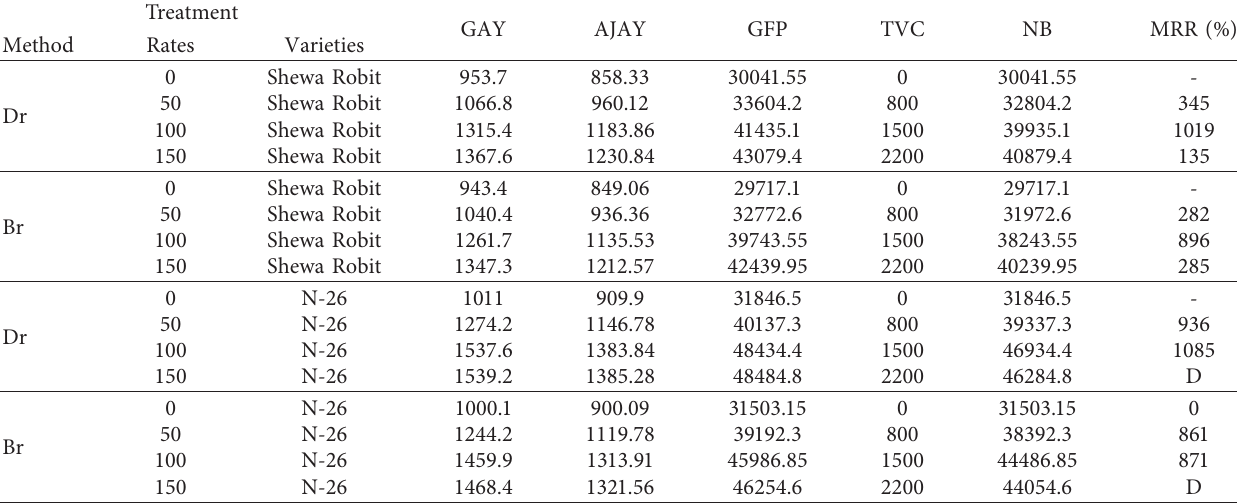
Table 5: Partial budget analysis of interaction effect of varieties and blended NPS rates with the application method on yield of mung bean during 2019 cropping season at